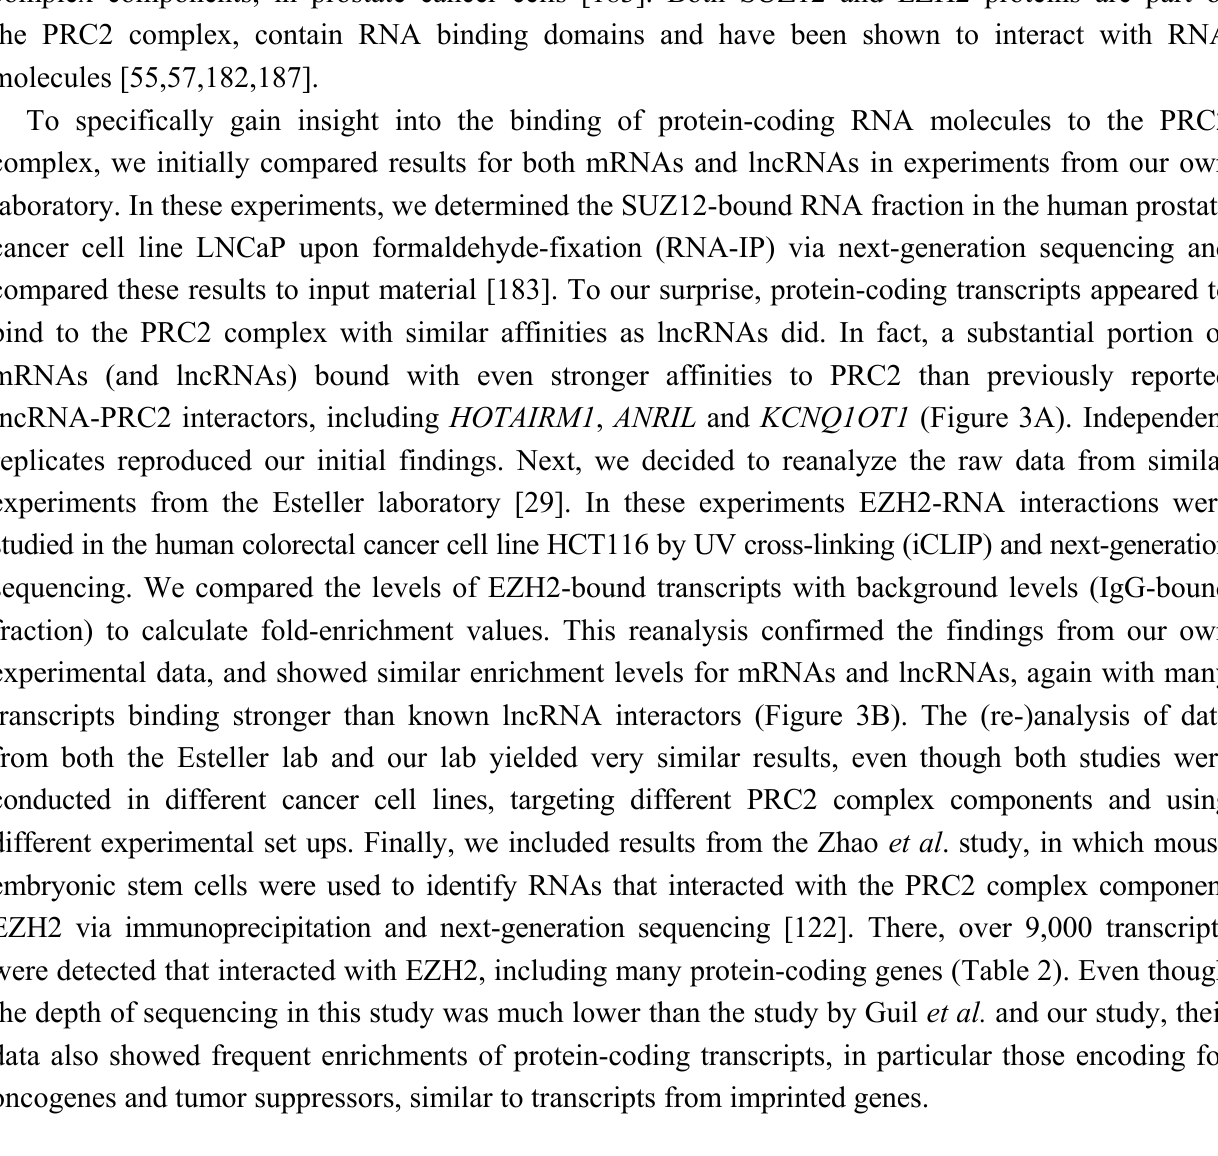
Table 2. EZH2-binding transcripts in mouse ES cells. Table is adapted from Zhao and colleagues